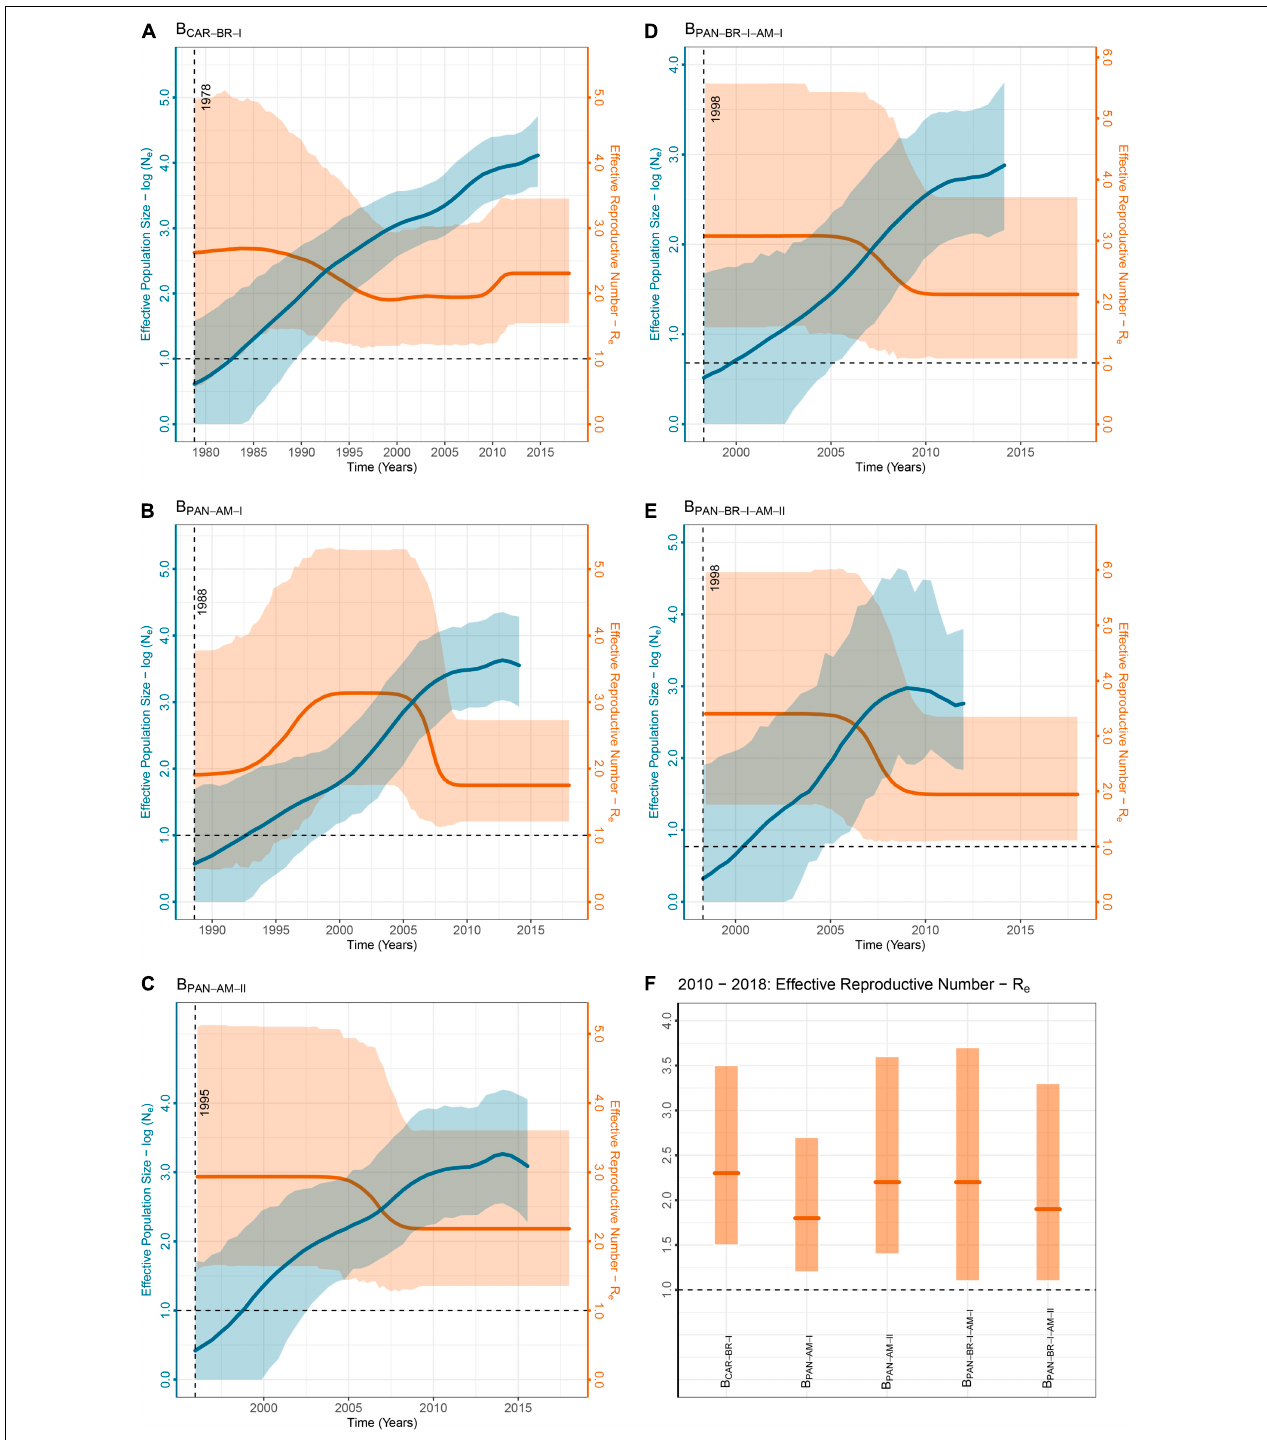
FIGURE 4 | Demographic history of subtype B cluster in Brazil’s Amazonas state. Each plot (A–E) details the demographic history of one subtype B large cluster ( n ≥ 30) in Amazonas from the pandemic (B PAN ) and non-pandemic (B CAR ) forms. The graphs exhibit their effective number of HIV-1 infections under the Bayesian Skygrid (BSKG) model in blue (N e , y -left-axis), and their effective reproductive number under the Birth-death Skyline (BDSKY) model in orange (N e , y -right-axis). For both parameters are indicated their median (solid lines) and 95% HPD intervals (pale areas) estimates. A dashed vertical line indicates the TMRCA of the clades, accompanied by its median value. The last graph (F) compares the R e obtained for the five clusters in the last period of analysis (2010–2018). For each cluster, its median R e (solid line) and 95% HPD interval (pale area) inferred values are represented.